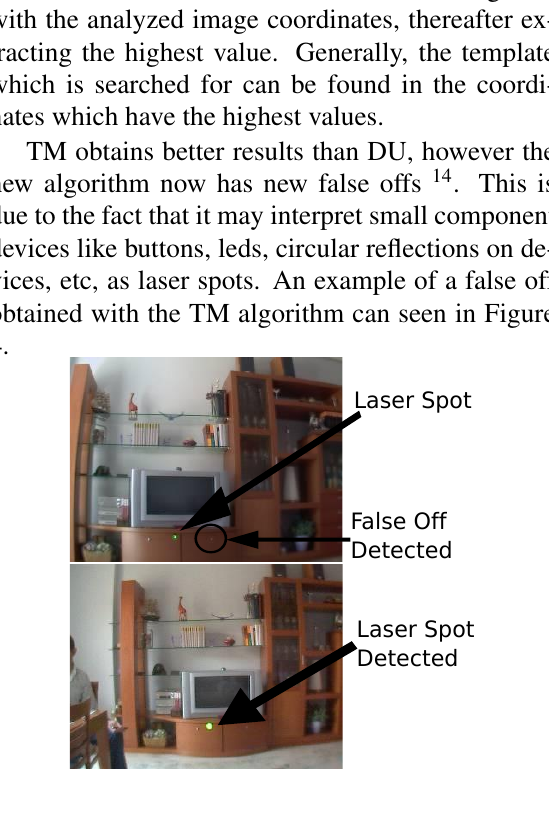
Fig. 4. False off and success using the TM technique